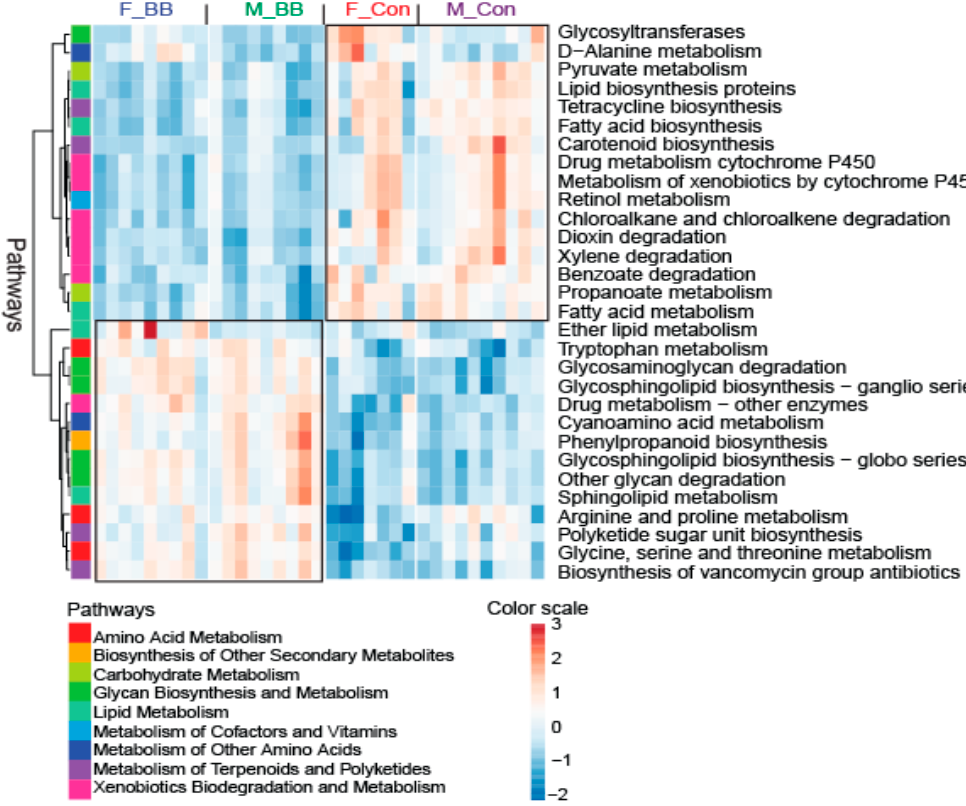
Figure 5. The PICRUSt-predicted biological function pathways upon blueberry supplementation. The metabolic pathways from KEGG module predictions used 16S data with PICRUSt and sequenced shotgun metagenomes. F-BB (female mice fed a blueberry diet) ( n = 9), F-Con (female mice fed a control diet) ( n = 7), M-BB (male mice fed a blueberry diet) ( n = 9), and M-Con (male mice fed a control diet) ( n =